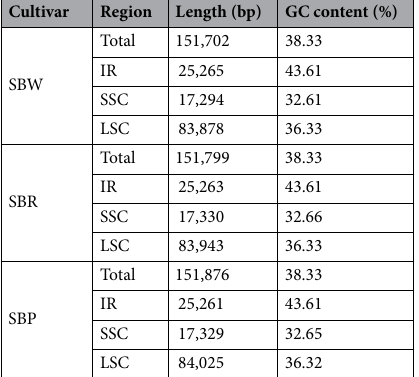
Table 1. Summary of the cp genome features for the three cultivated varieties. LSC: large single-copy region; SSC: small single-copy region; IR: inverted repeat.